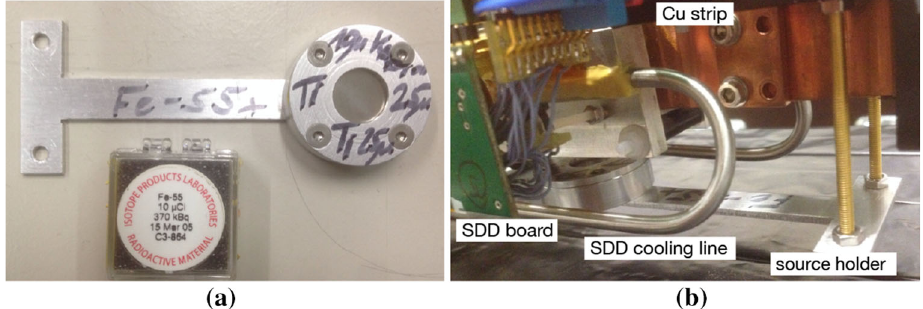
Fig. 4 a The holder of the source with the Fe-55 source inside covered by a 25 µ m thick high purity titanium foil; b a photo of the holder mounted near the copper strip and the